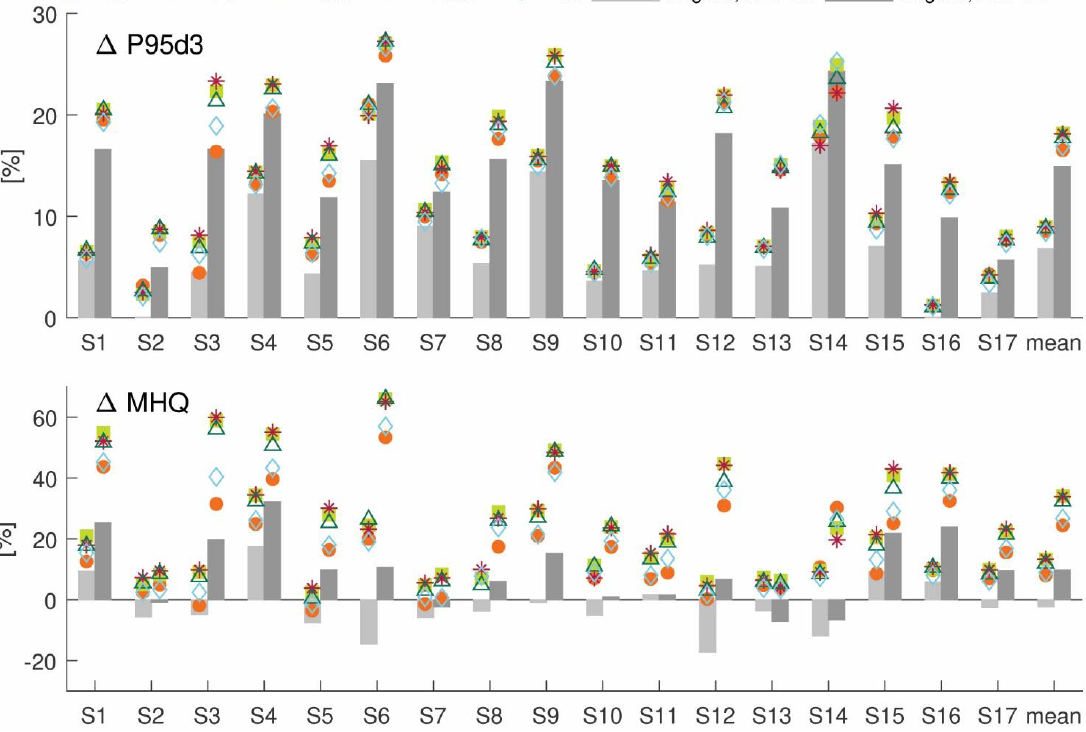
Figure 5. Climate change signals for P95d3 and MHQ for 17 climate scenarios for the non-corrected climate scenario data and differently bias-corrected data as mean of the grid cells for the whole area (P95d3) or as weighted mean by catchment size (MHQ) for the period 2070–2099 compared to the historical period 1971–2000. The correction methods are: linear scaling (LS), power transformation (PT), distribution mapping (DM), LOCI and the ISI-MIP approach (IM).